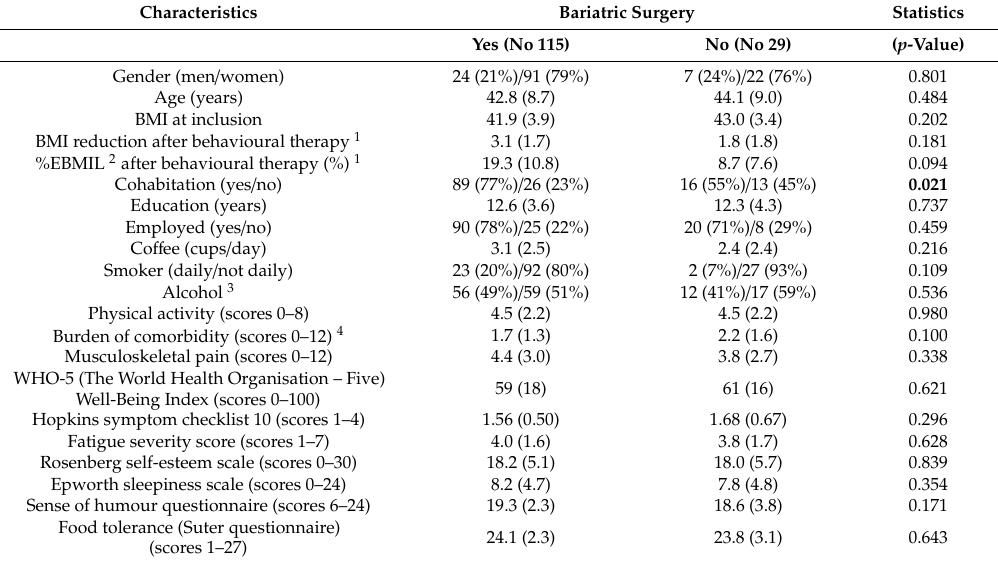
Table 1. Characteristics at inclusion of subjects with and without bariatric surgery.